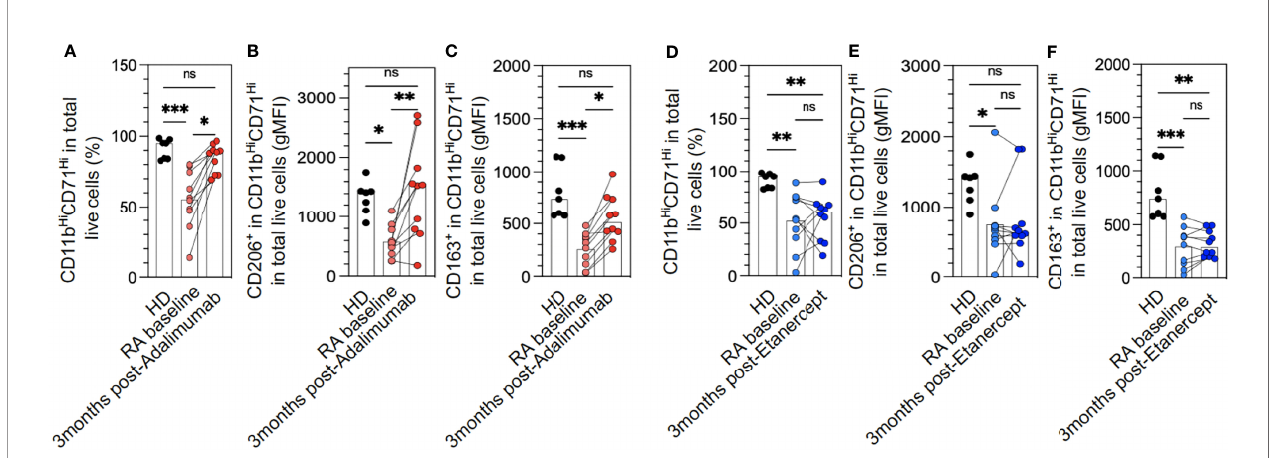
FIGURE 2 | M2-like macrophage polarization defect in rheumatoid arthritis (RA) monocytes is restored with adalimumab (ADA) but not etanercept (ETA) treatment. The differentiation of frozen peripheral blood mononuclear cells (PBMCs) to M2-like macrophages was assessed in healthy donors (HDs) (n = 7) and RA patients at baseline and divided upstream between patients who would receive ADA (A – C) or ETA (D – F) (n = 20), RA at 3 months after ADA (n = 10, red dots), and RA at 3 months after ETA (n = 10, blue dots) by fl ow cytometry analysis using anti-CD11b and anti-CD71 antibodies (A, D) . Speci fi c markers of M2-like macrophage polarization were assessed: CD206 (B, E) and CD163 (C, F) . Results are shown as symbols, lines, and mean ± SEM and were compared by Kruskal – Wallis test with Dunn ’ s multiple comparisons. * p < 0.05, ** p < 0.01, and *** p < 0.001. ns, not signi fi